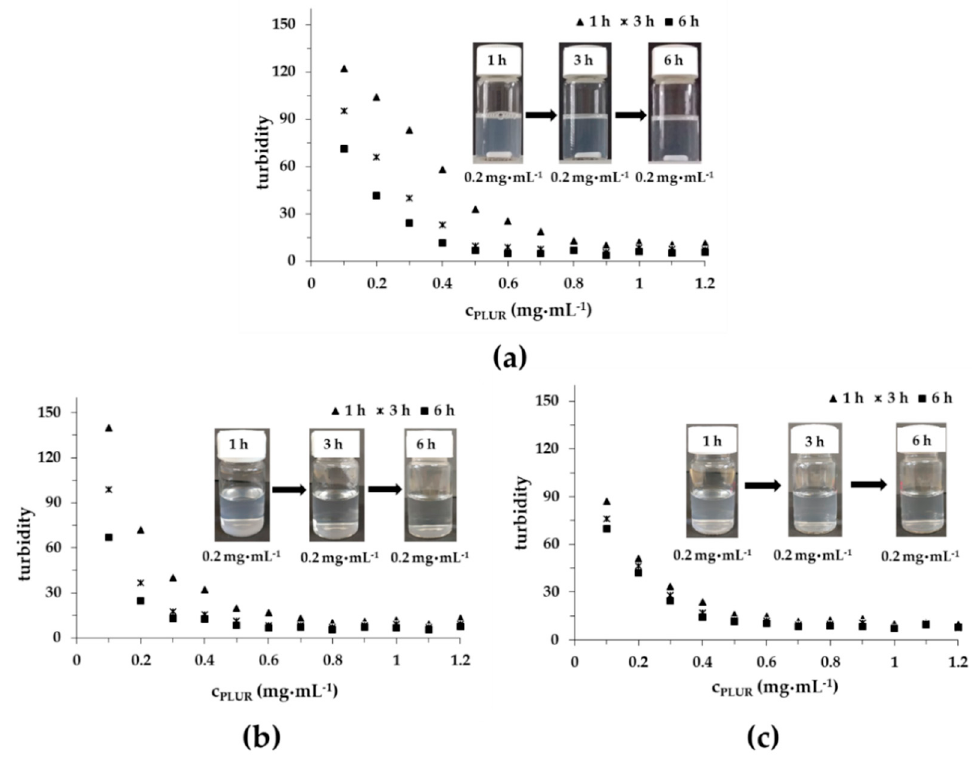
Figure 5. The turbidity of the TP in the PLUR solution at 25 °C in an aqueous medium ( a ), in a PBS buffer at 25 °C ( b ) and at 37 °C ( c ) (pH = 7.4, 0.9 w / w % NaCl) (c TP = 0.05 mg·mL − 1 ).